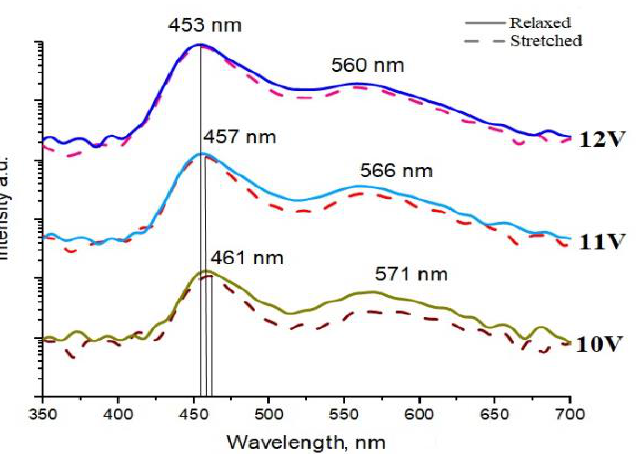
Figure 5. EL spectra of a representative LED in relaxed ( solid line ) and stretched ( dashed line ) states obtained under different applied voltages. The EL spectra are vertically shifted for